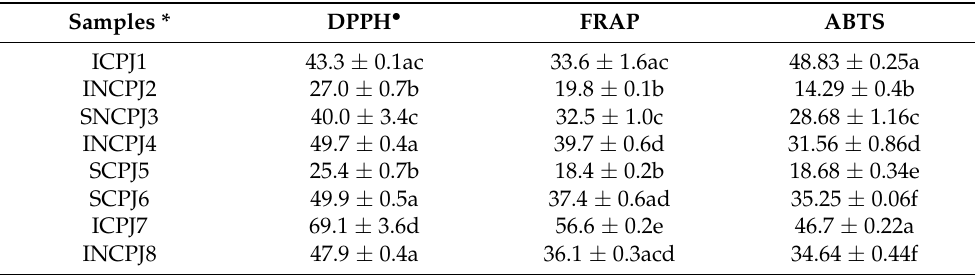
Table 5. Antioxidant activity ( µ mol TE/mL) of PJs evaluated according to different methods. Samples